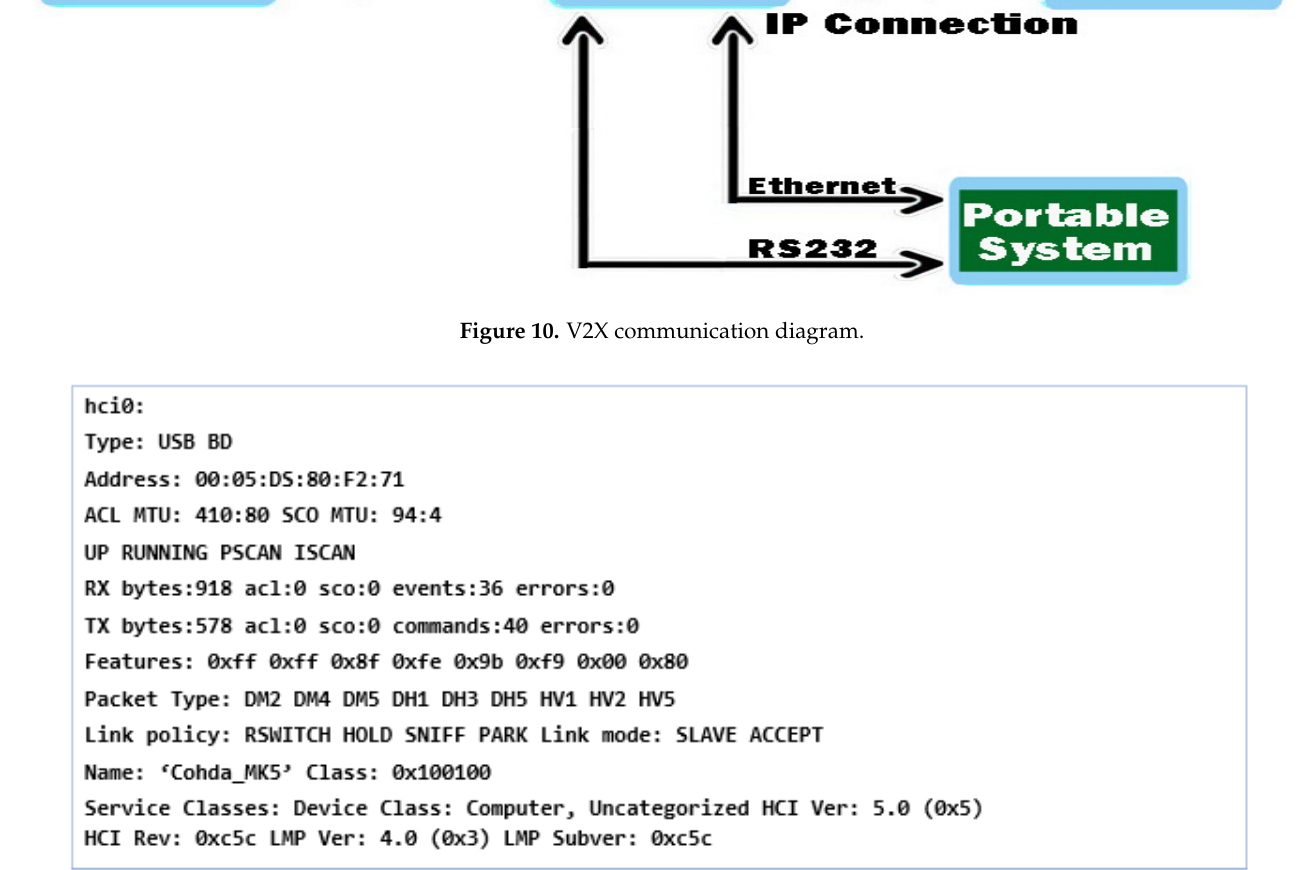
Figure 11. Initialization of the device and the host control interfaces.